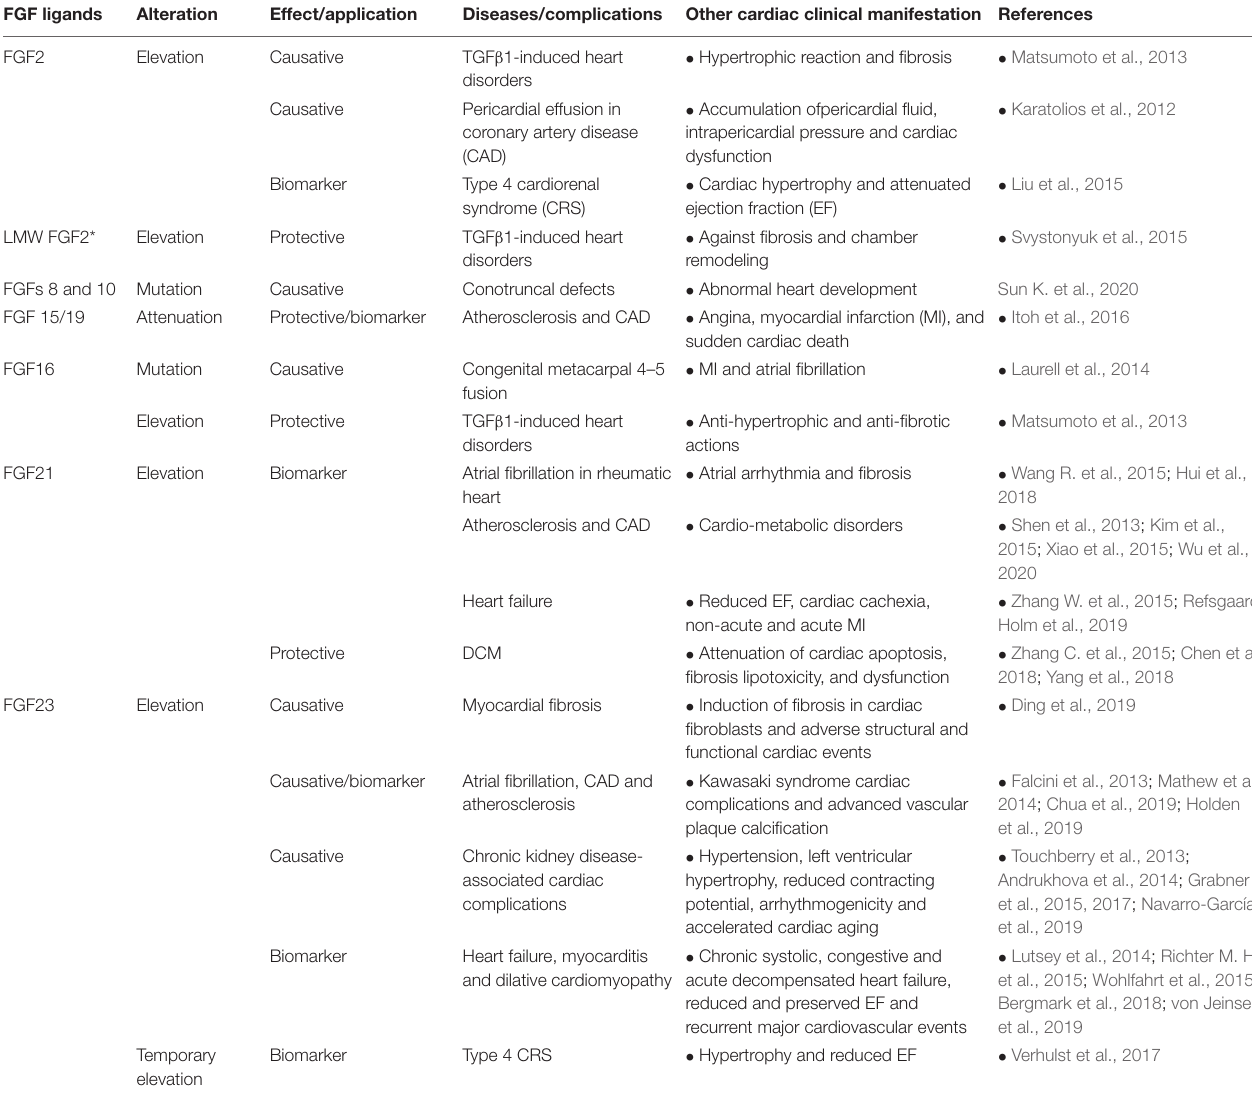
TABLE 3 | Secreted FGFs involved in/against cardiac pathogenicity and their potential as serum biomarker in